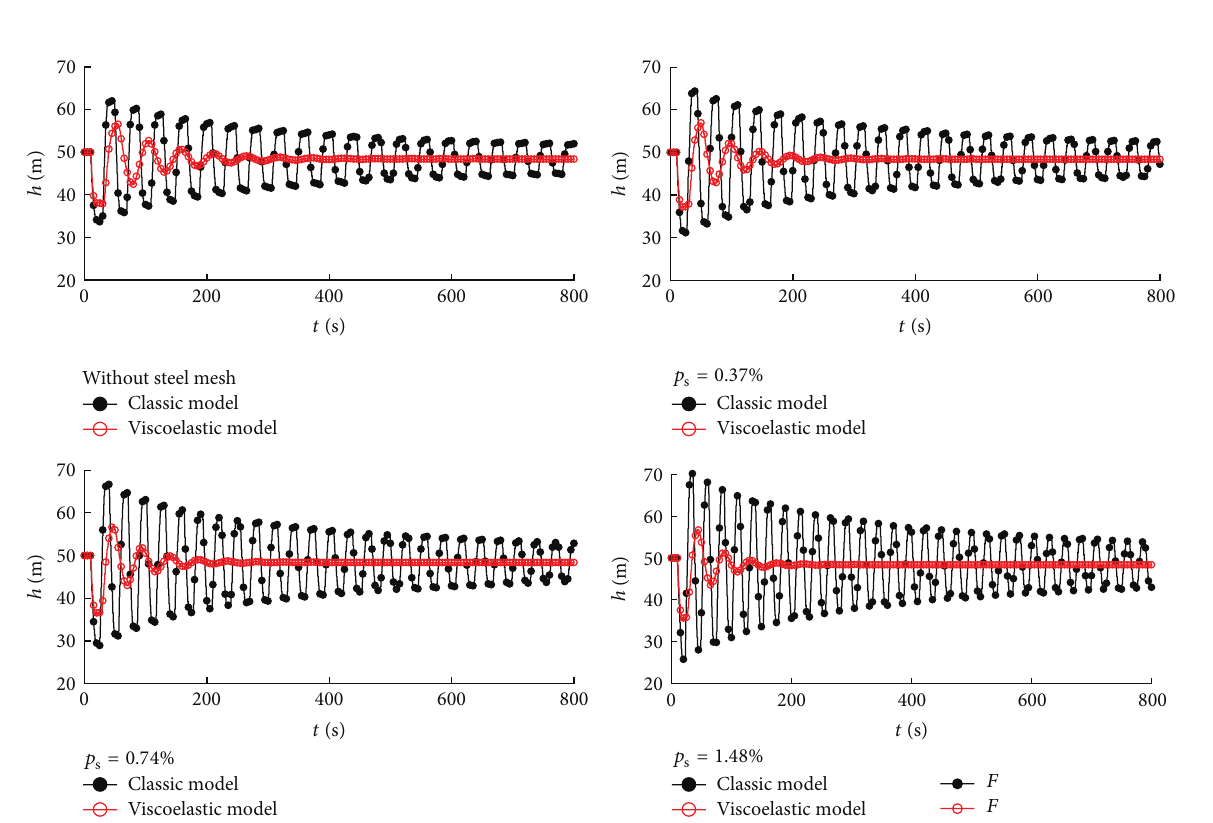
Figure 12: Comparison of pressure waves by different transient models.